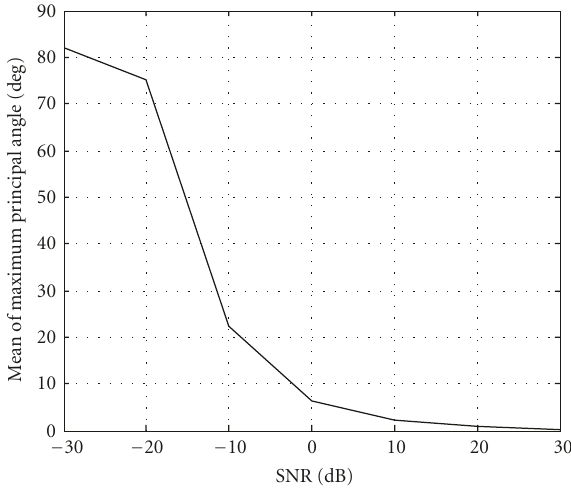
Figure 8: Mean of maximum principal angle versus SNR for two stationary sources located at [ − 50 ◦ , 50 ◦ ] .